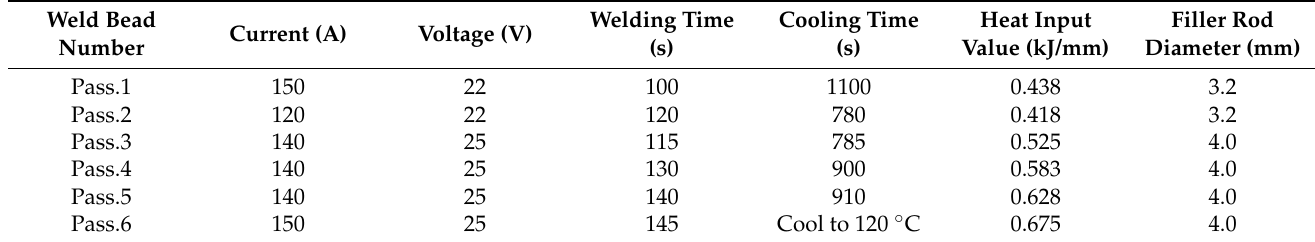
Table 2. Technological parameters of the welding process.